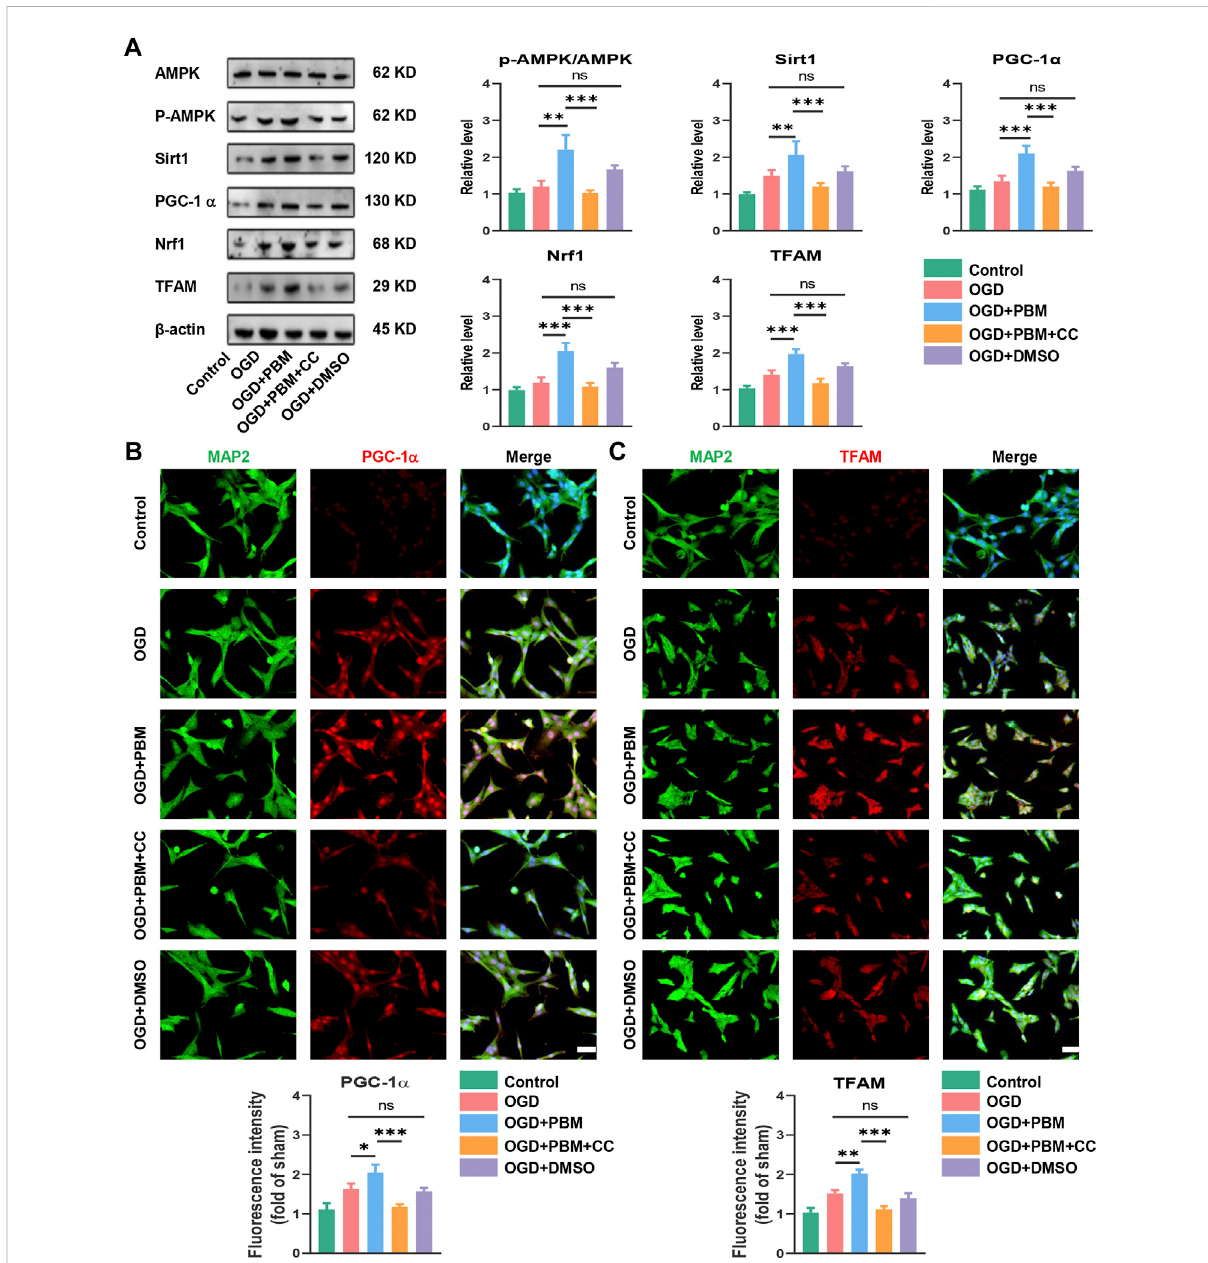
FIGURE 5 PBM activated AMPK/PGC-1 α /TFAM pathway in vitro . (A) : Western blot analysis and quanti fi cation of p-AMPK/AMPK, PGC-1 α ,TFAM, Sirt1, and Nrf1expressionlevelsineachgroup, n =4. (B) :RepresentativeimagesofVSC4.1(MAP2,green) andPGC-1 α (red)foreachgroup. Nucleiwerestained with DAPI(blue). Quanti fi cation ofthe intensity of PGC-1 α relative to that inthecontrol group, Scalebar: 50 µm, n = 3. (C) : Representative imagesof VSC 4.1 (MAP2,green) and TFAM (red) for each group. Nuclei were stained with DAPI (blue). Quanti fi cation of the intensity of TFAM relative to that in the control group, Scale bar: 50 µm n =